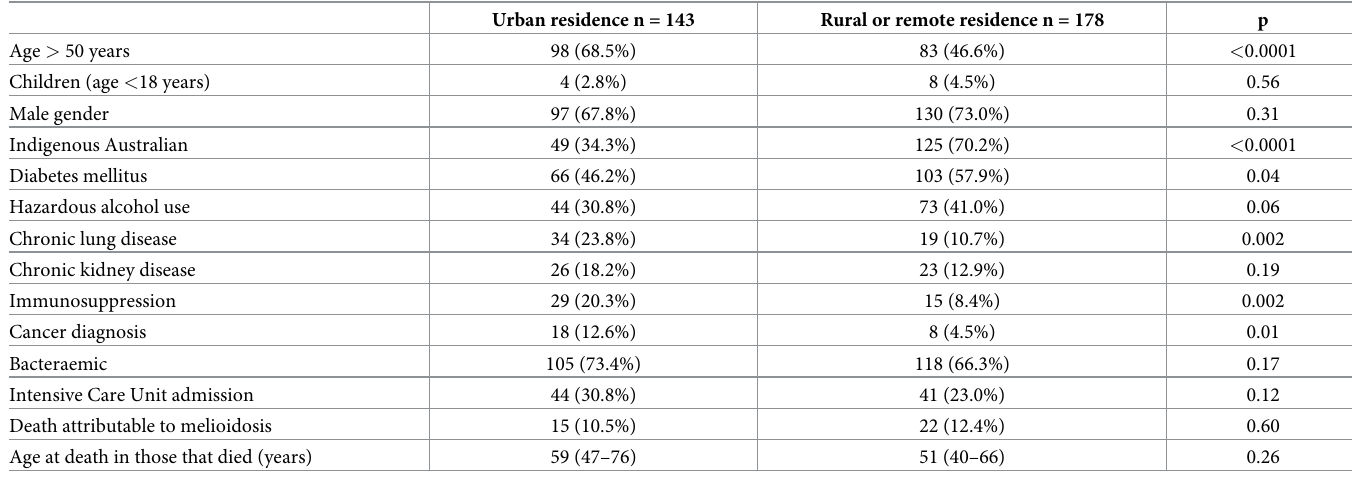
Table 2. Selected characteristics of the cohort stratified by rural/remote